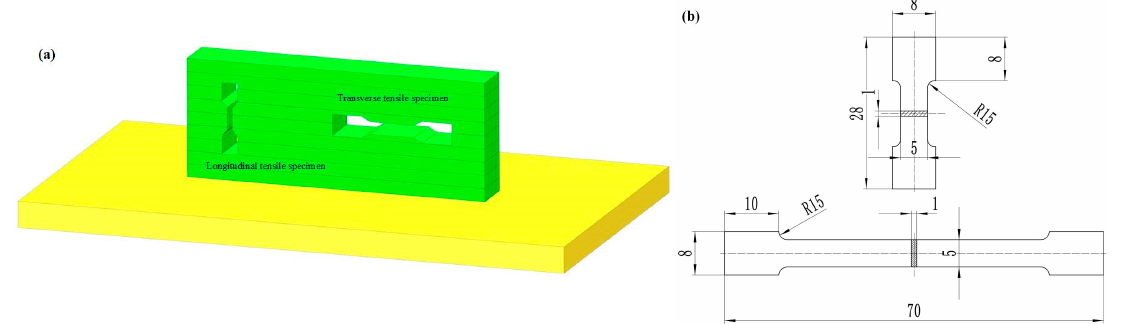
Figure 2. Specimen preparation ( a ) schematic diagram of specimen preparation, ( b ) specimen preparation dimensions.